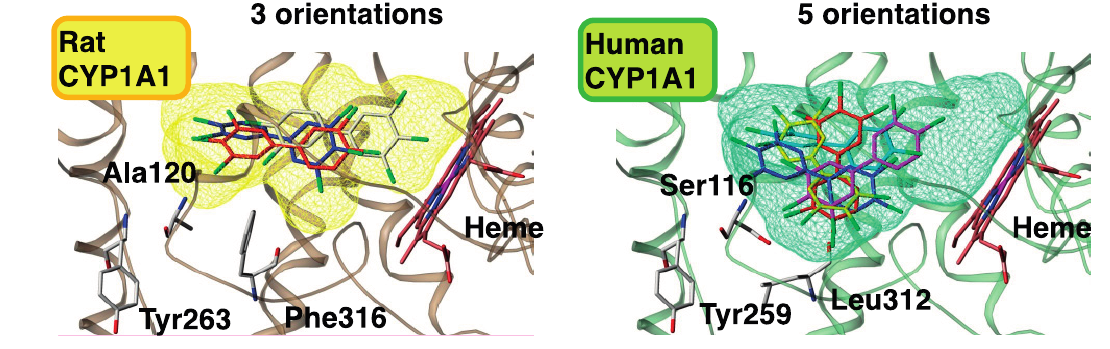
Figure 5. Docking models of CB126 into rat and human CYP1A1s. Orientation numbers of CB126 in a substrate-binding cavity ( A ) and conformation numbers of CB126 within 5 Å of the heme ( B ). Left and right panels show rat and human CYP1A1s, respectively. Yellow and green shades indicate substrate-binding cavities of rat and human CYP1A1s,